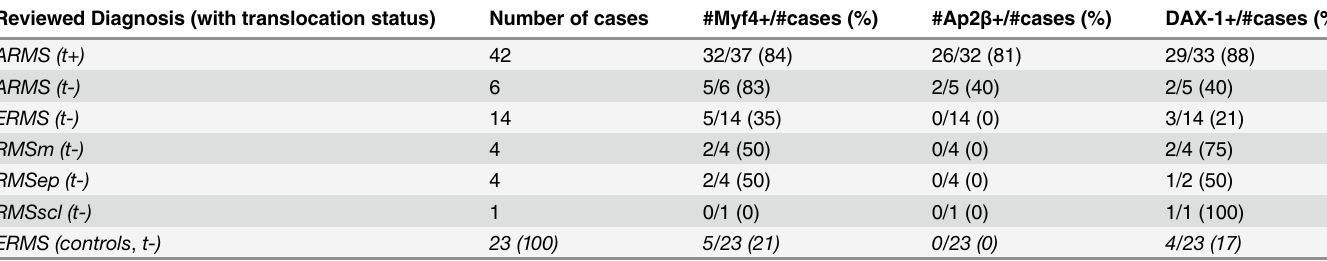
ARMS: Alveolar Rhabdomyosarcoma; t+: translocation positive; t-: translocation negative; ERMS: Embryonal Rhabdomyosarcoma; RMSm: